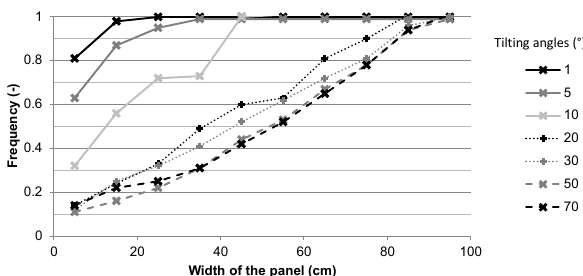
Figure 13. Influence of the transverse slope of the solar panels on the lateral rain redistribution along the width of the panel, tested for a 20mmh − 1 rain intensity and “prevalent” tilting angles of the panels between 1 and 70 ◦ . The results are expressed in a cumulative distribution of the collected amounts at the outlets placed along the width of the